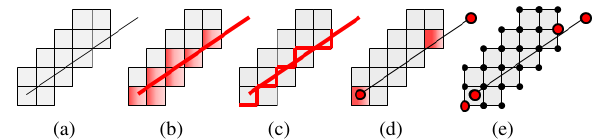
Figure 5. (a) Raster and vector representation of a line object, (b)-(e) exemplary definitions of correspondences ( red, bold